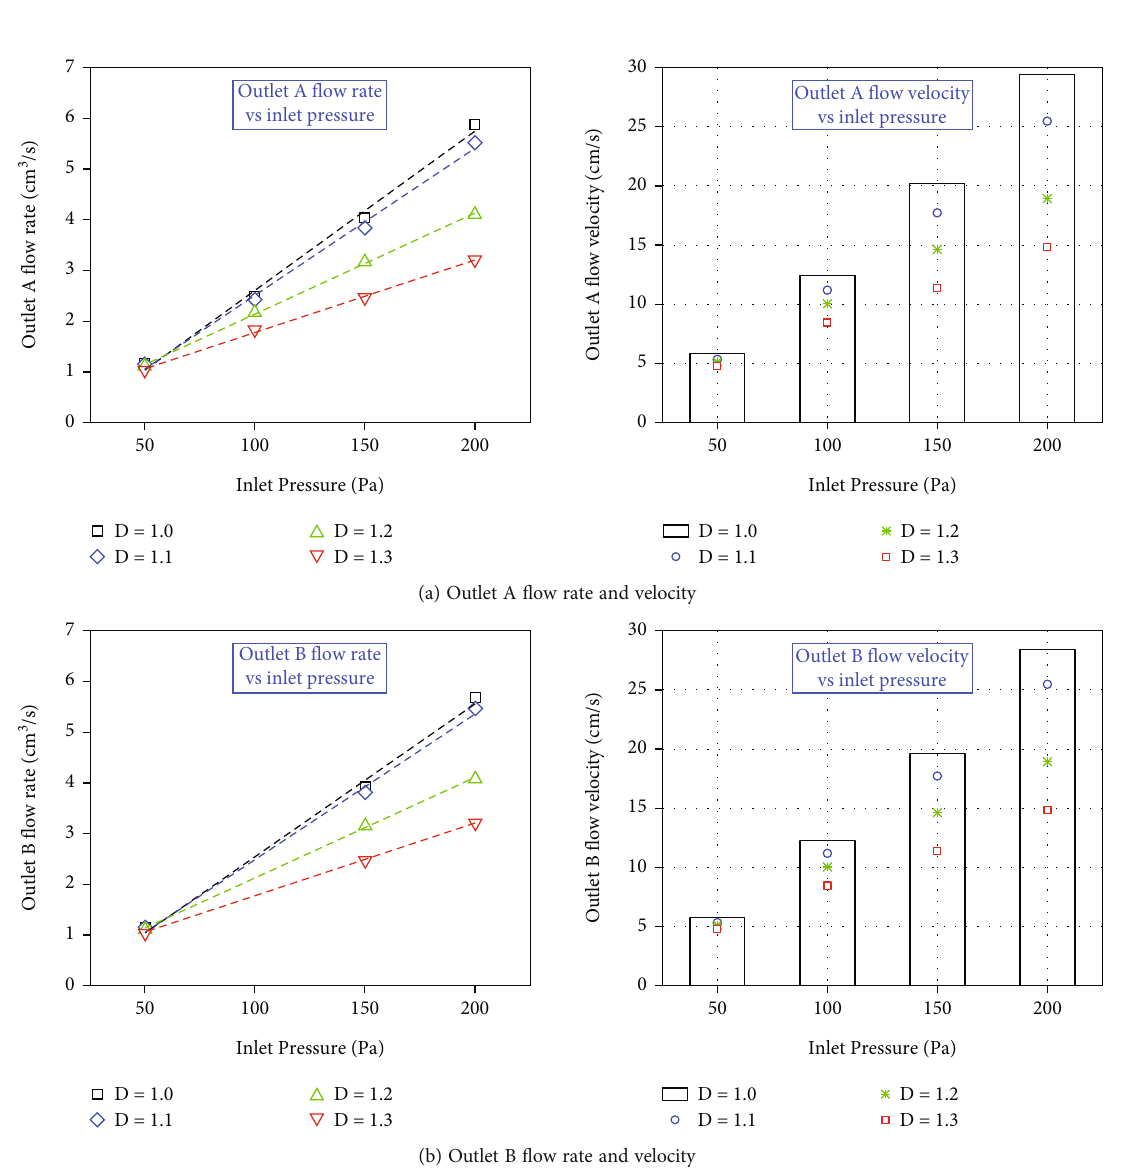
Figure 3: Evolution of fl ow and velocity with inlet